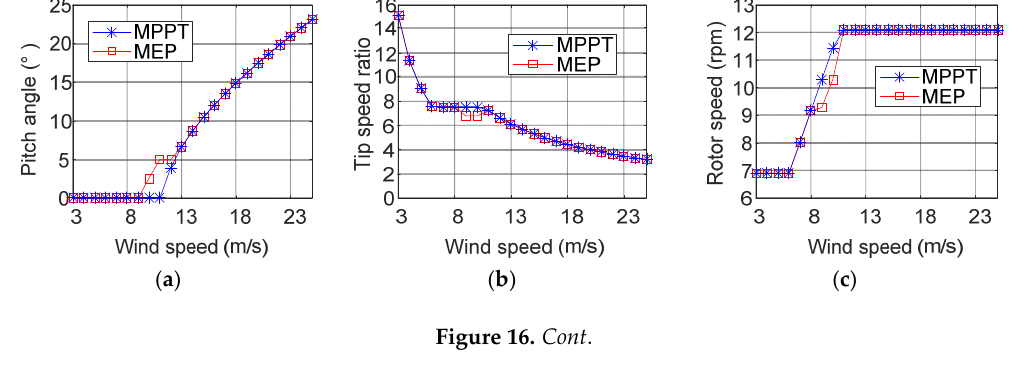
Figure 15. The active power, lifetime, and energy production in terms of the pitch angle and tip speed ratio at the wind speed of: ( a ) 7 m/s; ( b ) 9 m/s; ( c ) 11 m/s.